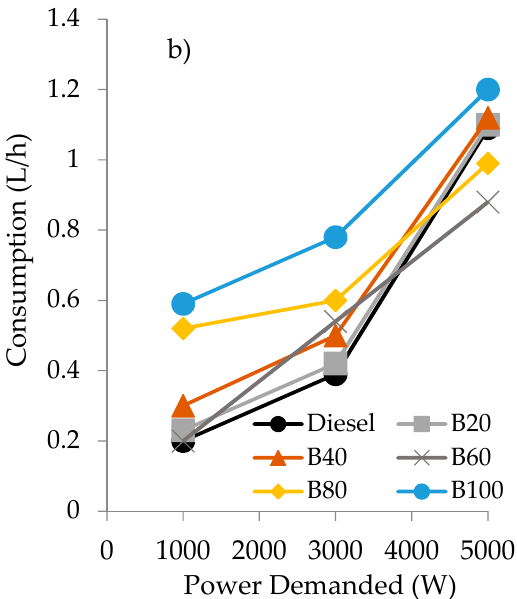
Figure 4. Consumption values as a function of the power demanded of the engine for the blends of diesel/gasoline/sunflower oil ( a ) and diesel/gasoline/castor oil ( b ).